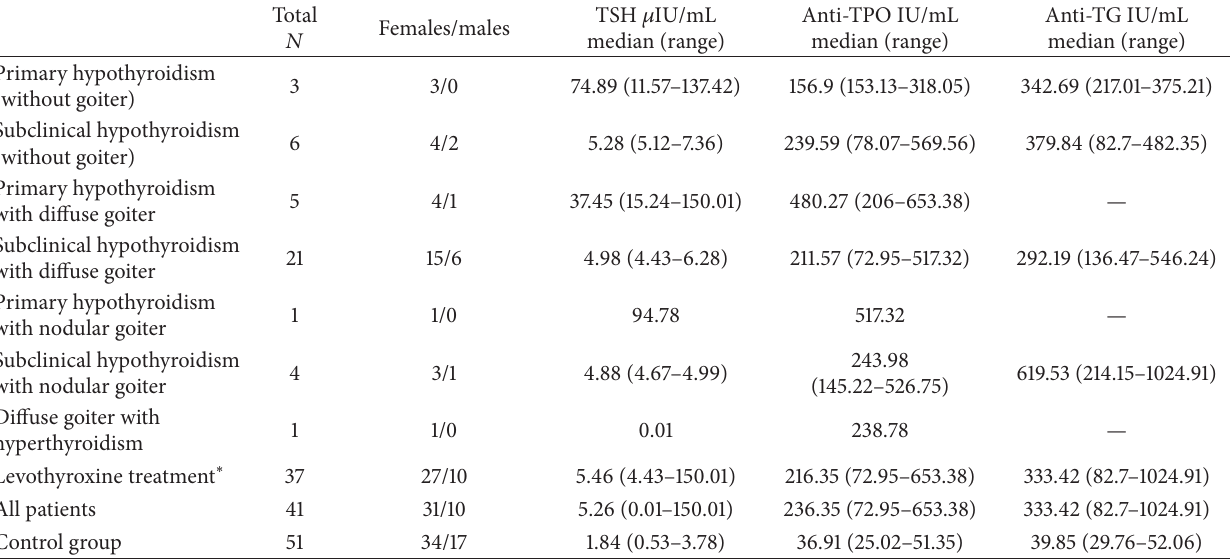
Table 1: Clinical characteristics of 41 patients aged 6 to 16 with autoimmune thyroiditis and the control group.